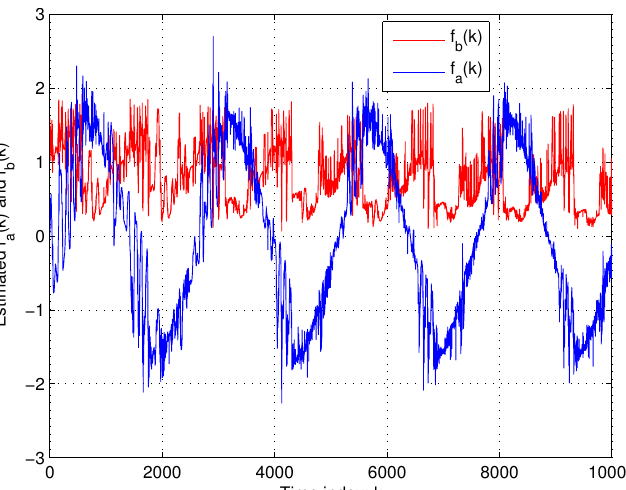
Figure 7. Control effort: u ( k ) .